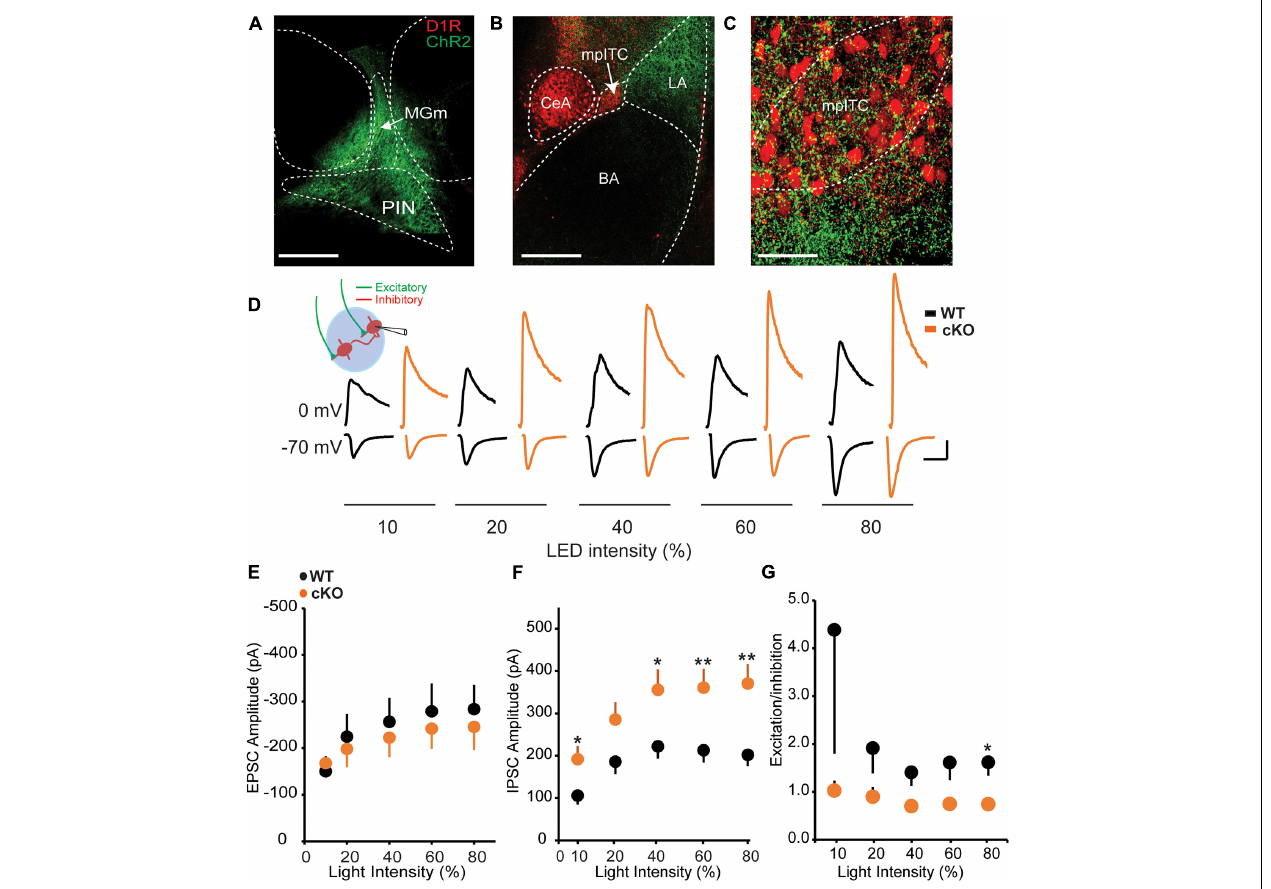
FIGURE 2 | Thalamic input-driven inhibitory transmission onto mpITCs is enhanced in cKO mice. (A) ChR-eYFP injection site in PIN/MGm. (B) ChR [AAV-hsyn-hChR2(H134R)]-eYFP–labeled afferents in amygdala. (C) Labeled fibers in mpITC cluster. (D) Sample traces of EPSCs and IPSCs recorded at –70 and 0 mV, respectively, in mpITCs while stimulating thalamic fibers. Scale bar: 100 pA, 30 ms. No difference in mean EPSC amplitudes (E) [WT: n = 19, cKO mice n = 15; two-way ANOVA, F (1,158), p = 0.6522] but IPSC amplitudes (F) were significantly enhanced in cKO mice at various light intensities [WT: n = 19, cKO mice n = 15; two-way ANOVA, F (1,154), p < 0.0001]. (G) E/I ratio was significantly reduced in cKO mice. [WT: n = 19, cKO mice n = 15; two-way ANOVA, F (1,152), p = 0.0199.] * p < 0.05; ** p <